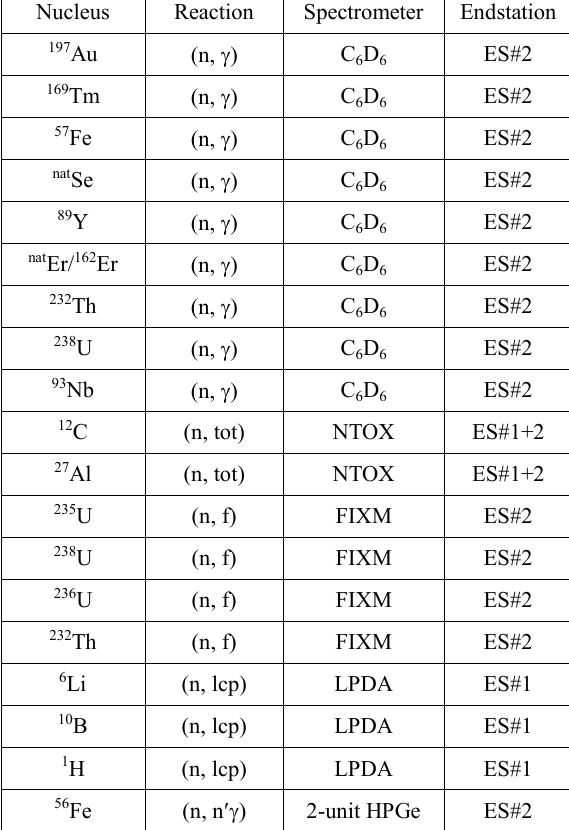
Table 2 . Nuclear data measurement experiments conducted at the Back-n Nucleus Reaction